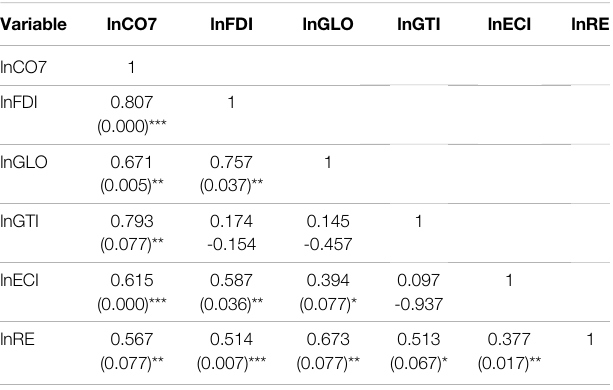
TABLE 2 | Correlational